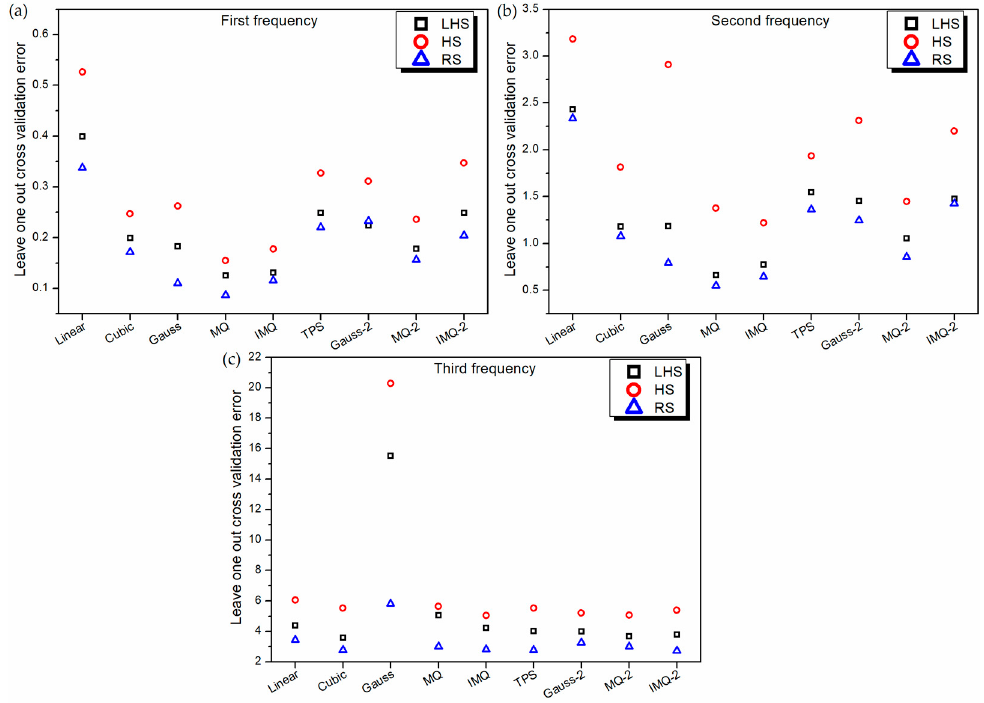
Figure 4. Leave-one-out cross-validation error of various RBF metamodels in LD problem.